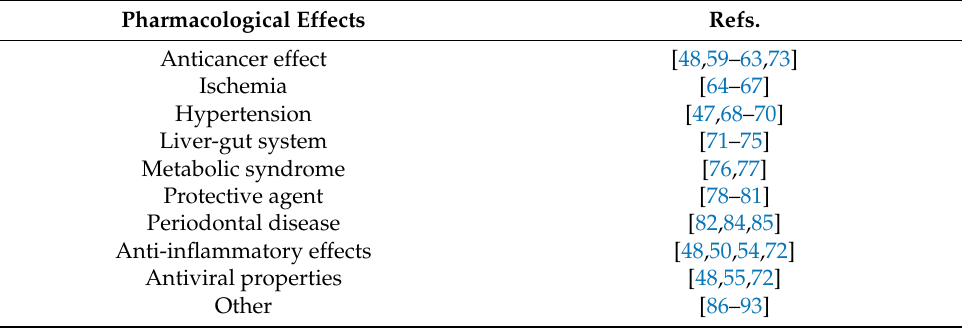
Table 2. The pharmacological aspects of